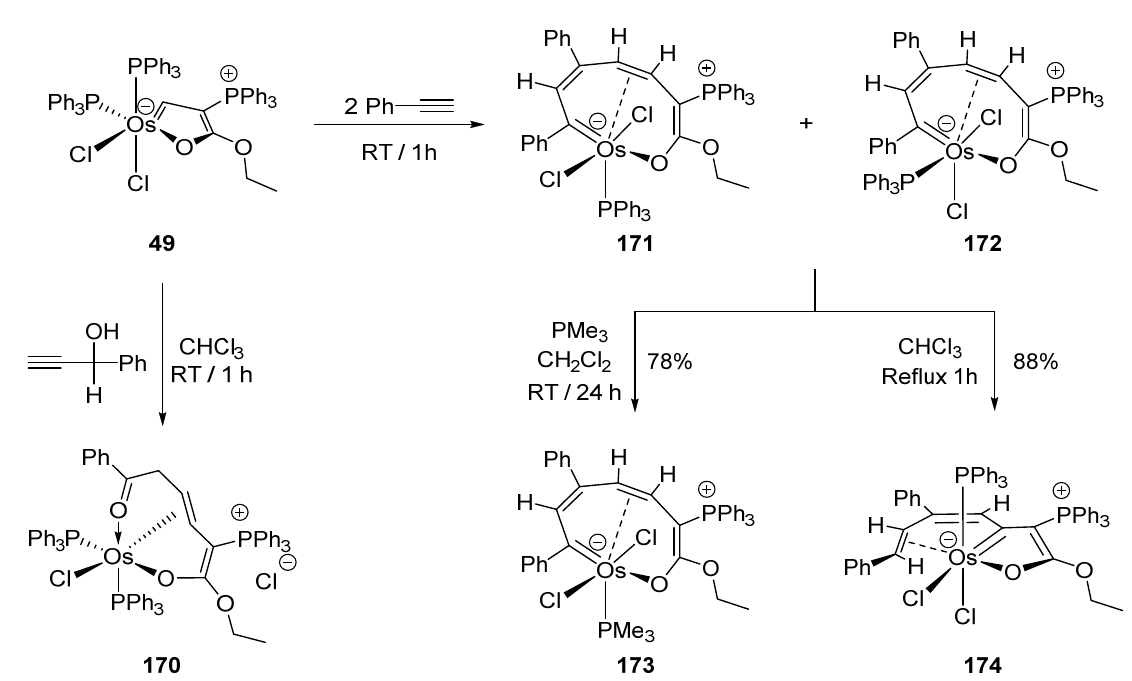
Figure 36. Ring-expansion reaction from a five-membered to a nine-membered osmacycle.